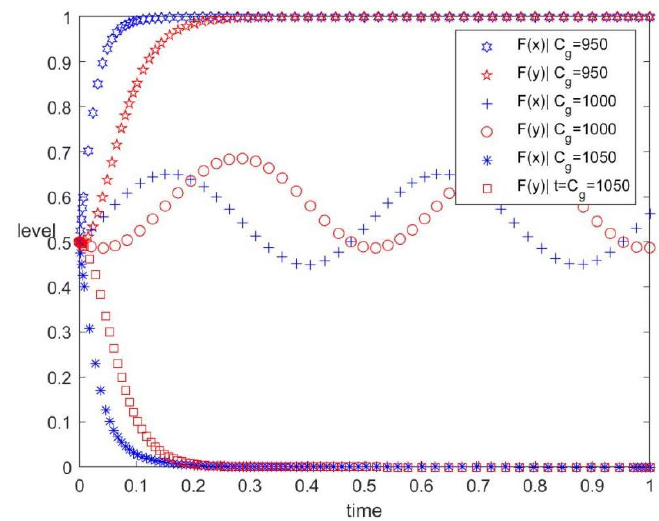
Figure 1. Evolution track under different regulatory costs.